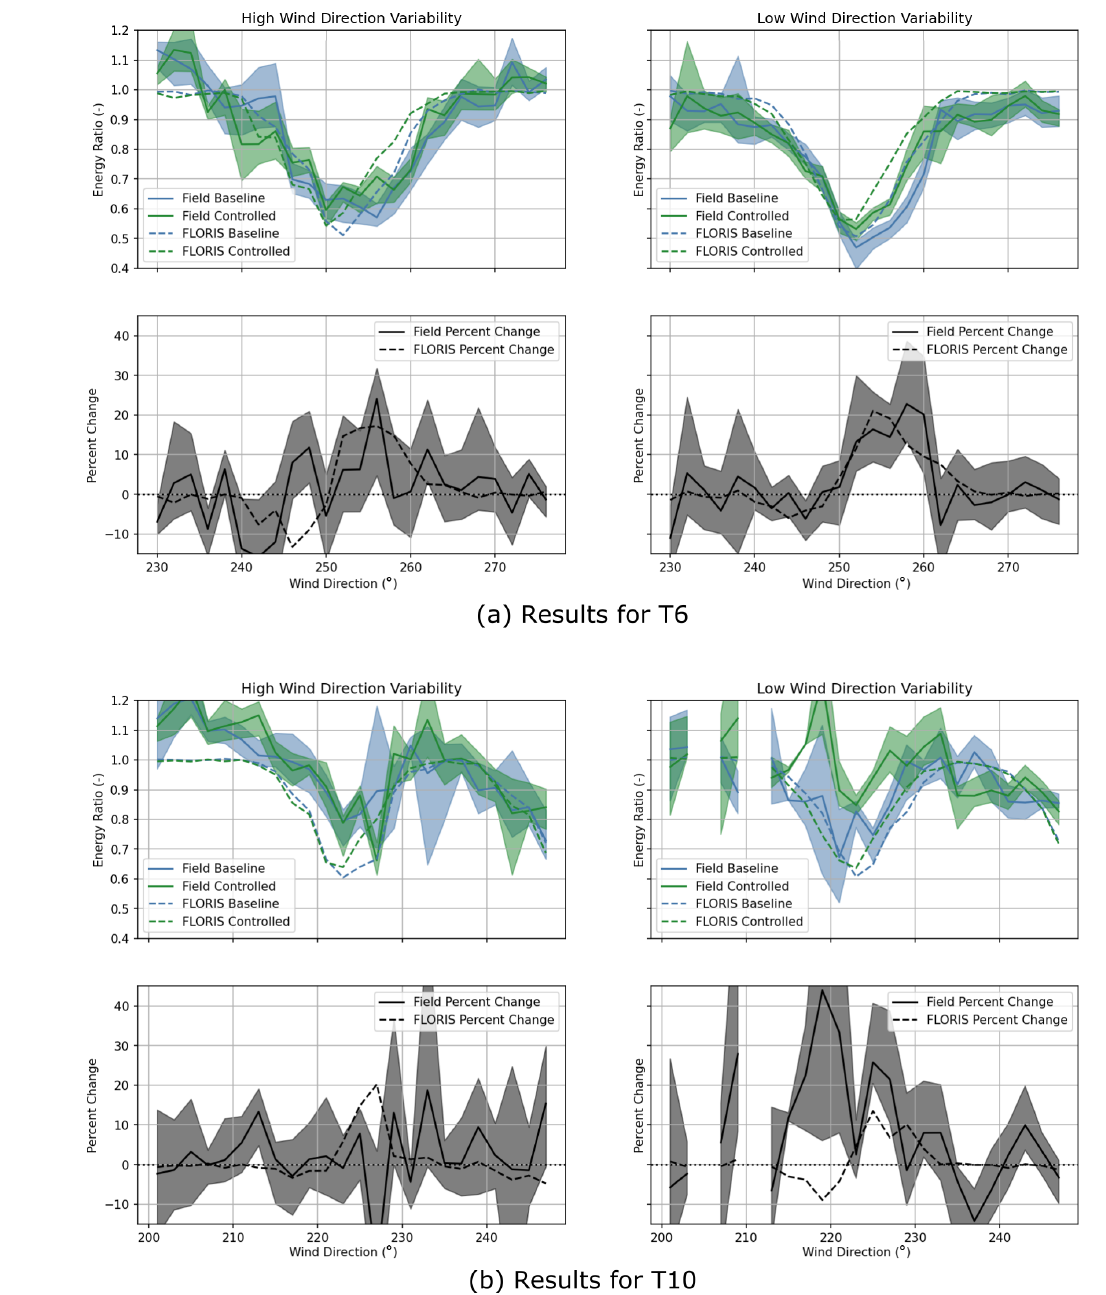
Figure 8. Energy ratio and change in energy ratio, as in Fig. 7, but divided into two subsets according to the wind direction variability measured by the reference wind turbine. As estimated by FLORIS, increasing the baseline offset of 7 ◦ to the controlled offset of 18.5 ◦ is only beneficial for a small sector of wind